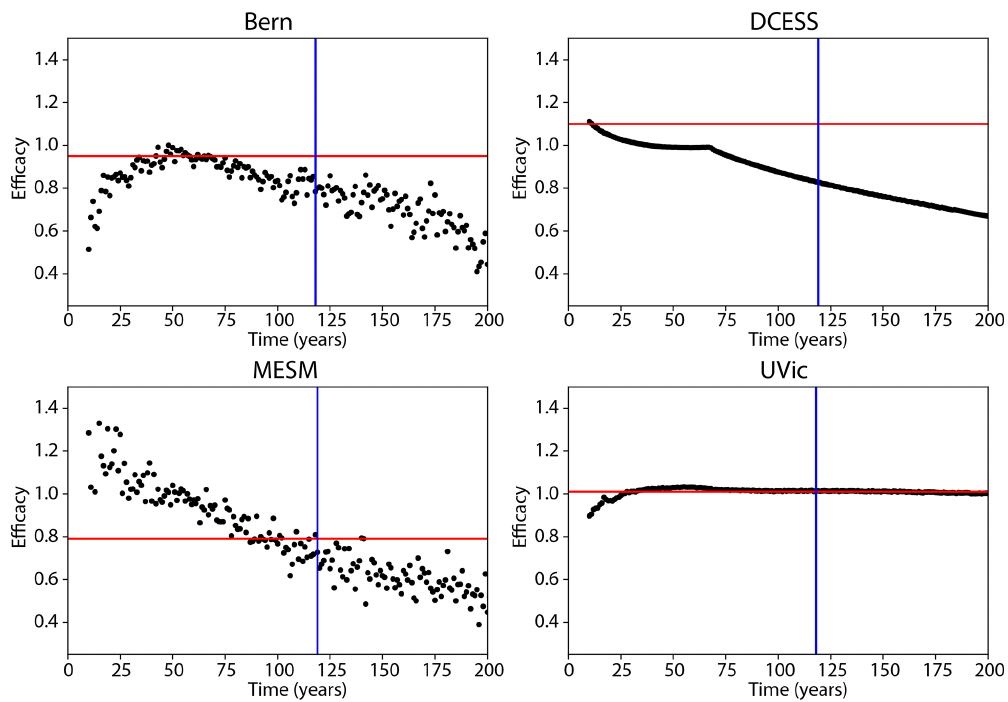
Figure D1. Evolution of efficacy for the four EMICs without substantial internal variability. The red horizontal line is the efficacy value estimated from the 1pctCO2 experiment, and the vertical blue line marks 50 years after emissions